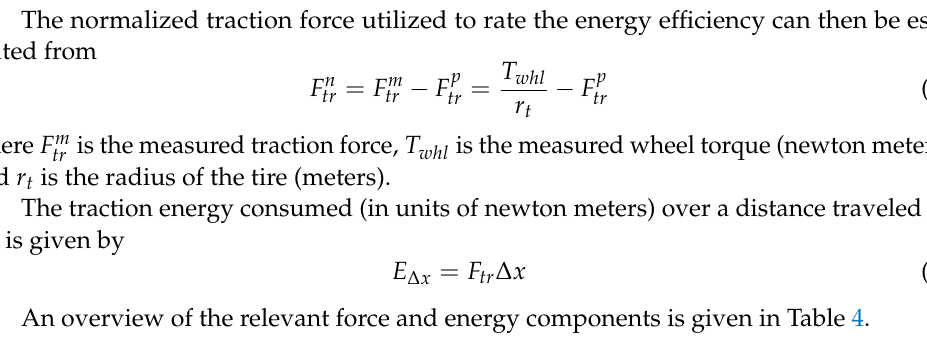
Table 4. Overview of the relevant energy components utilized in the present study. Measured Normalized Drag Tire Climbing Acceleration